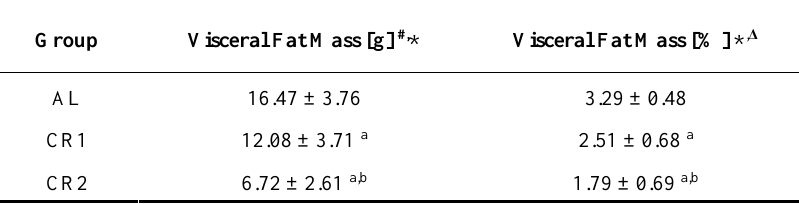
Table 3. Effect of calorie restriction on visceral adipose tissue †